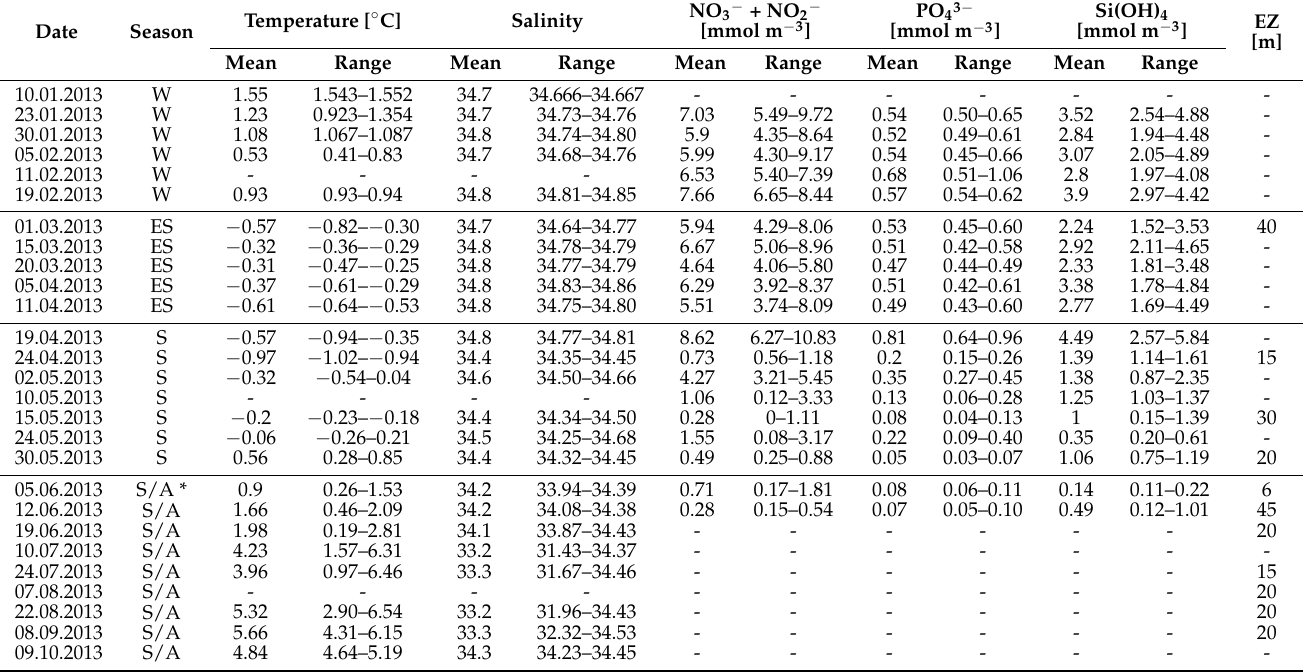
Table 1. Overview of sampling dates and environmental data (mean values and range: minimum and maximum) collected at the IsA station. Abbreviations: W–winter, ES–early spring, S–spring, S/A–summer/autumn, EZ–euphotic zone